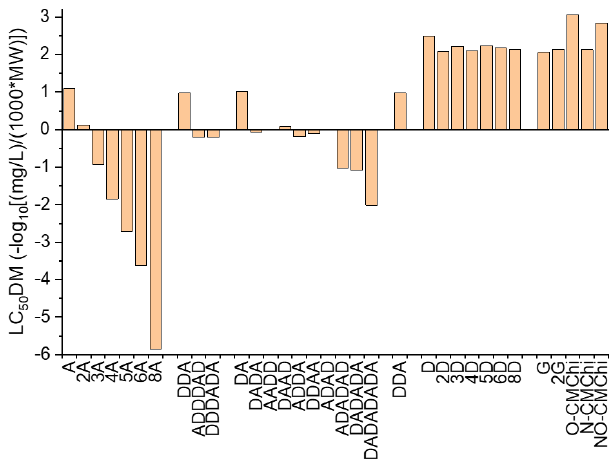
Figure 6. 48 h Daphnia magna LC 50 predicted values for chitooligosaccharides and their derivatives